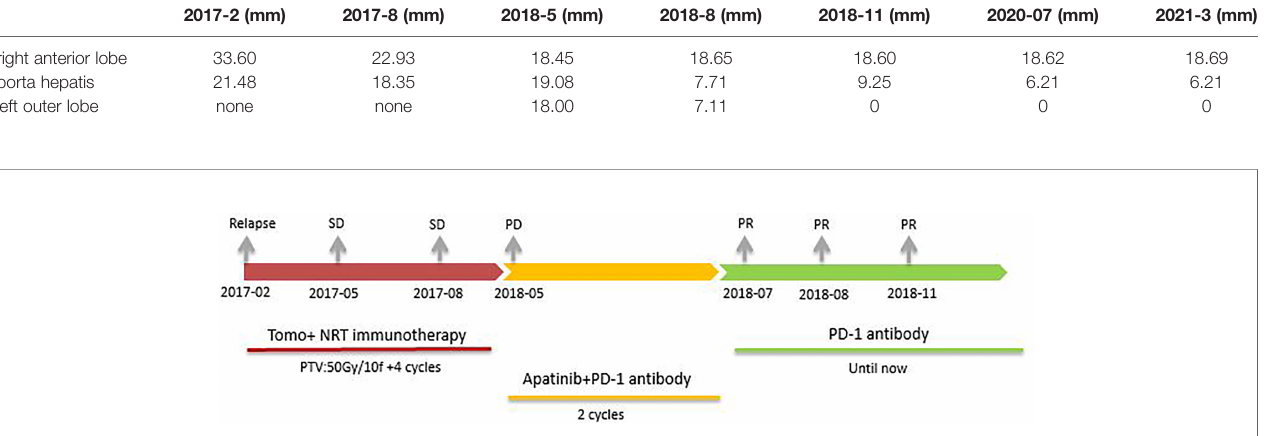
FIGURE 3 | The patient received different treatments at different times. Firstly, tomotherapy combined with Neoantigen Reactive T Cells based immunotherapy (2017-02 to 2017-08, SD). Secondly, PD-1 antibody combined with apatinib(2018-05 to 2018-07, PR). Finally, PD-1 antibody single-drug maintenance treatment (2018-07 until 2020-06, PR in porta hepatis and CR in left outer